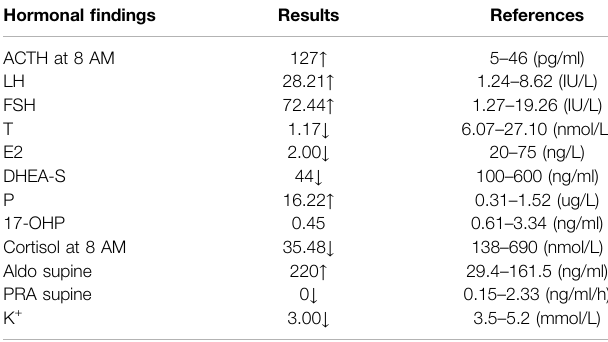
TABLE 1 | Hormonal fi ndings before treatment with dexamethasone. Hormonal fi